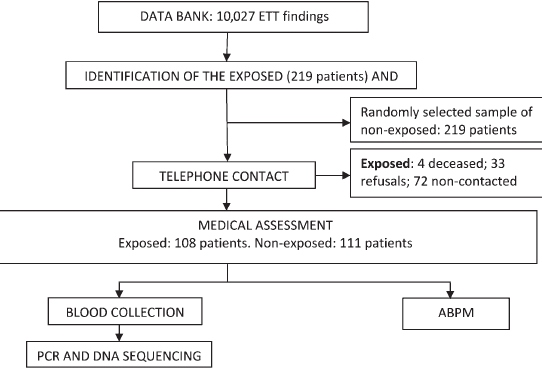
Figure 1. Study design. BP = blood pressure; EBPR = exaggerated BP response; ABPM = ambulatory BP monitoring.